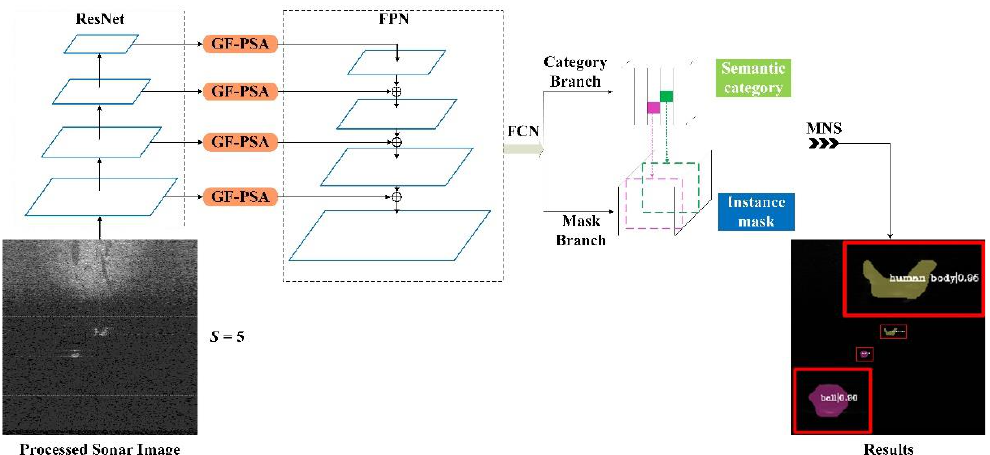
Figure 2. The structure of the proposed Attentive SOLO. The sonar image is log-transformed processed in order to artificially identify the location and category of the target. The GF-PSA module is embedded between the ResNet and FPN. In Section 4.4, we also embed the GF-PSA between the FPN and FCN.